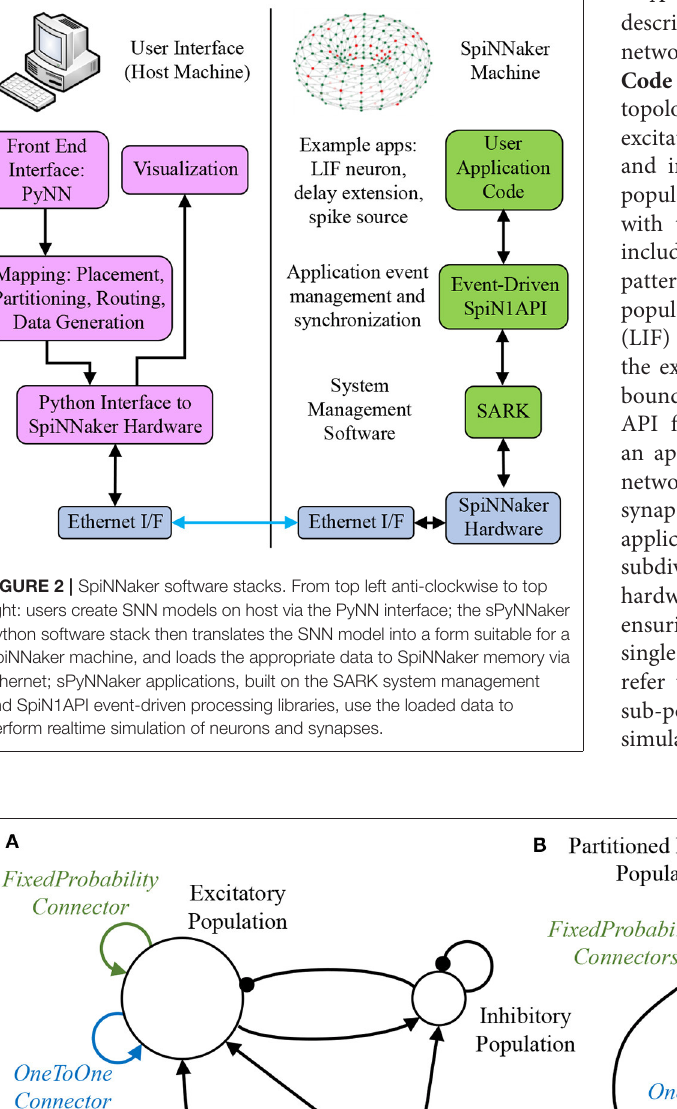
Frontiers in Neuroscience |